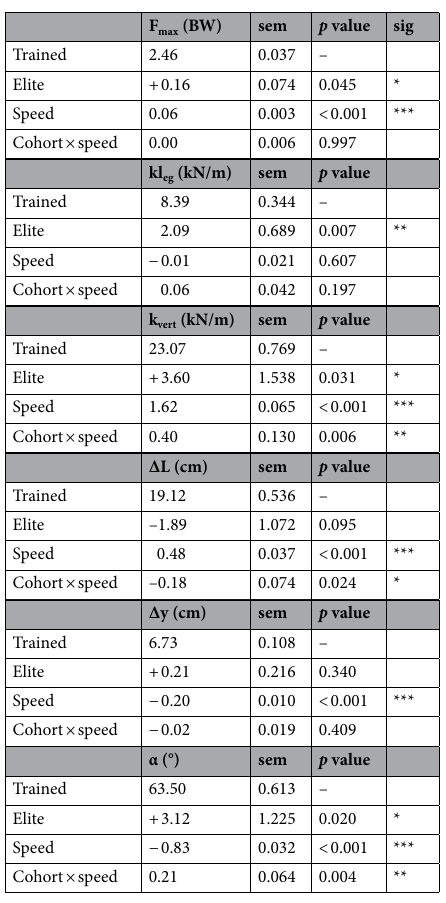
Table 3. Spring-mass characteristics with effects for cohort, speed, and the interactions. The values provided for the trained cohort correspond to the model estimate at 14 km/h, with the elite difference, speed-relation (all subject change per km/h), and cohort-speed interaction presented below that. Estimated standard errors are provided for each effect 68 . Statistical significance of each effect is indicated as: * p < 0.05, ** p < 0.01, and *** p <